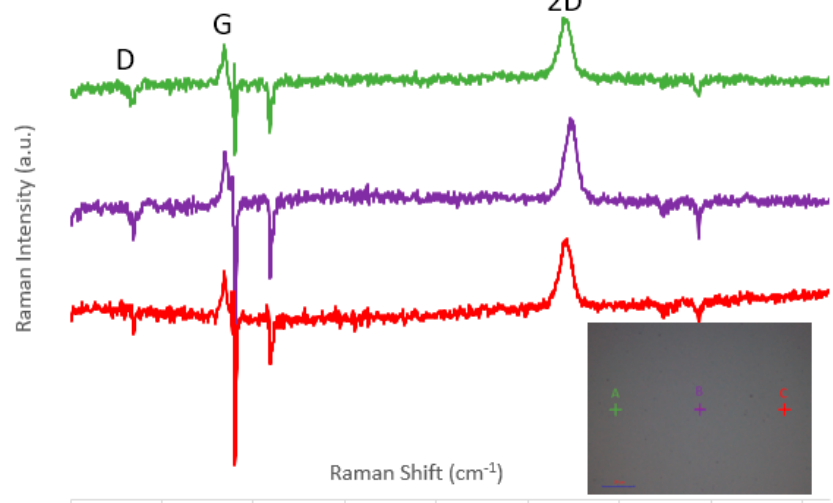
Figure 3. Raman Spectrum of graphene with in-plane vibrational mode (G), second order overtone (2D), and defect site (D) identified. Each Raman measurement was taken with a 532 nm, 2 mW Laser, with an exposure time of 5 s over an area of 25 µ m. Inset: Image of Chemical Vapor Deposition (CVD) graphene on Polyethylene terephthalate.